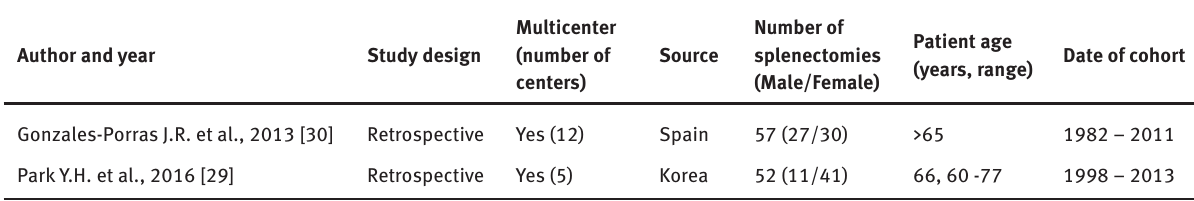
Table 2: Baseline characteristics of included studies